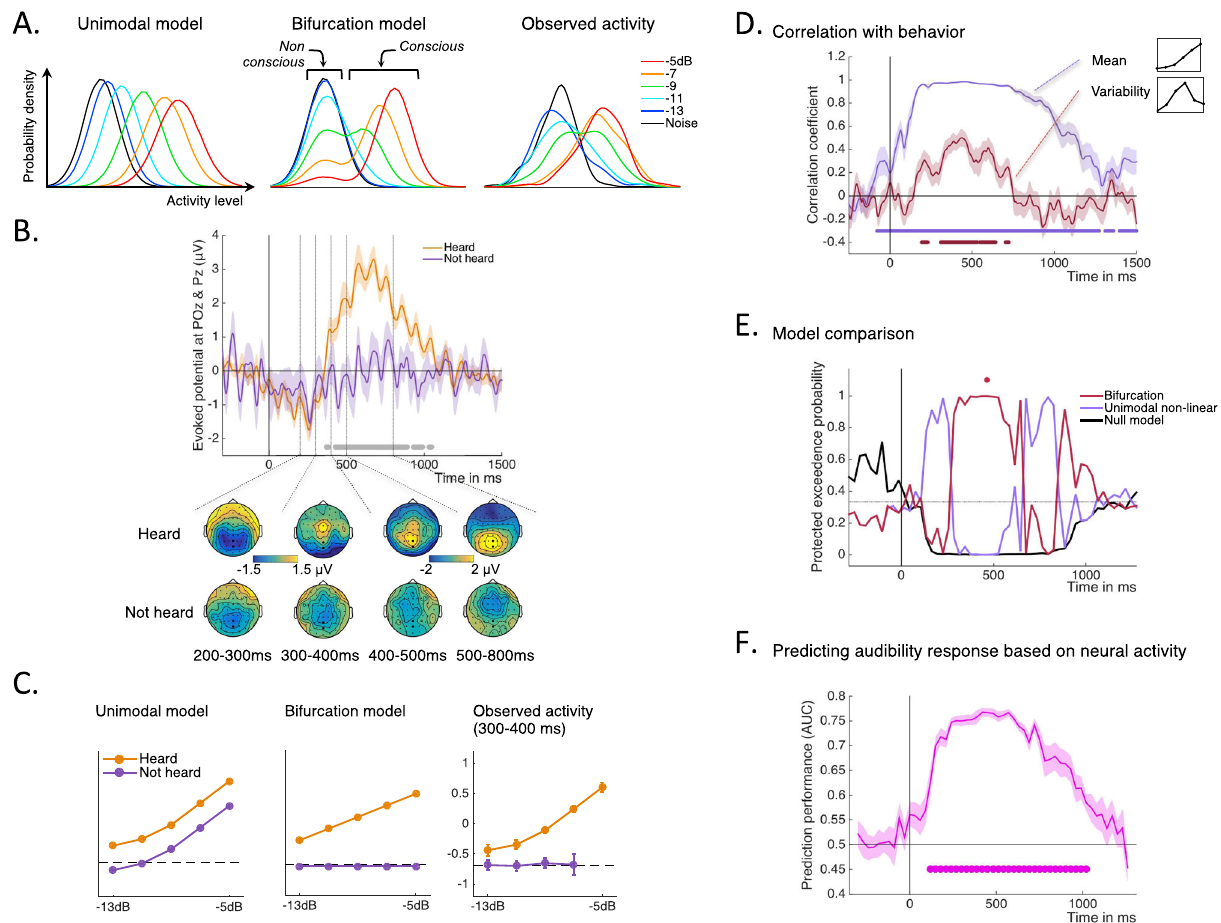
Fig. 3 Correlation with behavior, Bayesian model comparison, and prediction of conscious reports in the active session. A Predicted distributions of activity across trials as a function of SNR level for unimodal non-linear and bifurcation models (left and middle) compared with distributions of multivariate neural activity observed within the 400 – 500 ms time window for participant 14. B Grand average evoked potentials at electrodes POz and Pz for stimuli at threshold ( − 7 dB), shown separately for “ heard ” and “ not heard ” trials. Shaded area shows SEM ( n = 20 participants), gray dots represent time points where the difference is signi fi cant at p -corrected <0.05 (two-sided paired t -tests, FDR correction). Below are shown the corresponding topographies at various time windows. C Mean activity as a function of stimulus strength, shown separately for “ heard ” versus “ not-heard ” trials. Model predictions for the unimodal model (left) and bifurcation model (middle) are compared to the mean projected activity that was actually observed for “ heard ” and “ not heard ” trials during the 300 – 400ms time window (grand average across participants, arbitrary unit, error bars represent SEM, n = 20). D Correlation coef fi cient between the individual mean pro fi le (blue) or variability pro fi le (red) of projected neural activity with the corresponding mean or variability pro fi le in subjective audibility. The shaded areas correspond to SEM ( n = 20 participants). The periods of signi fi cant correlation are denoted as thick lines of the corresponding color (one-sided t -tests, p < 0.05, FDR corrected). E Bayesian model comparison: protected exceedance probability at the group level for the unimodal non-linear, bifurcation, and null models. F Prediction of behavioral audibility from the neural projected activity under the assumption of bifurcation dynamics. Group average performance in predicting trial-by-trial audibility responses (heard versus not-heard) is shown for intermediate SNRs ( − 11, − 9, and − 7 dB). Thick dots denote periods were prediction performance was better than chance (two-sided t -tests, p < 0.05, FDR corrected). The shaded areas correspond to SEM ( n = 20 participants). Source data for this fi gure are provided as a Source data fi